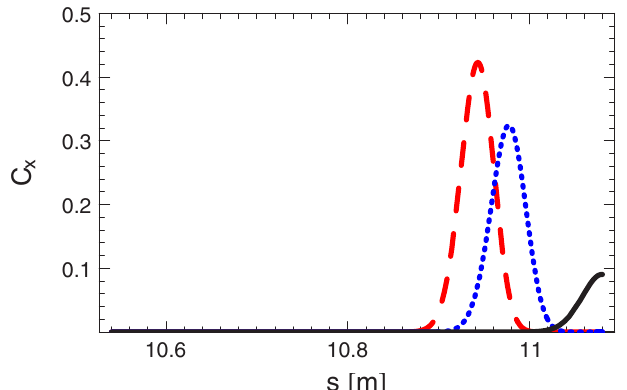
FIG. 11. (Color) Calculated transverse coupling factor in BC2 second dipole (from s ¼ 10 : 54 m to s ¼ 11 : 08 m ) for QM21 ¼ 27 kG (black solid curve), 23 kG (blue dotted curve), and 21 kG (red dashed